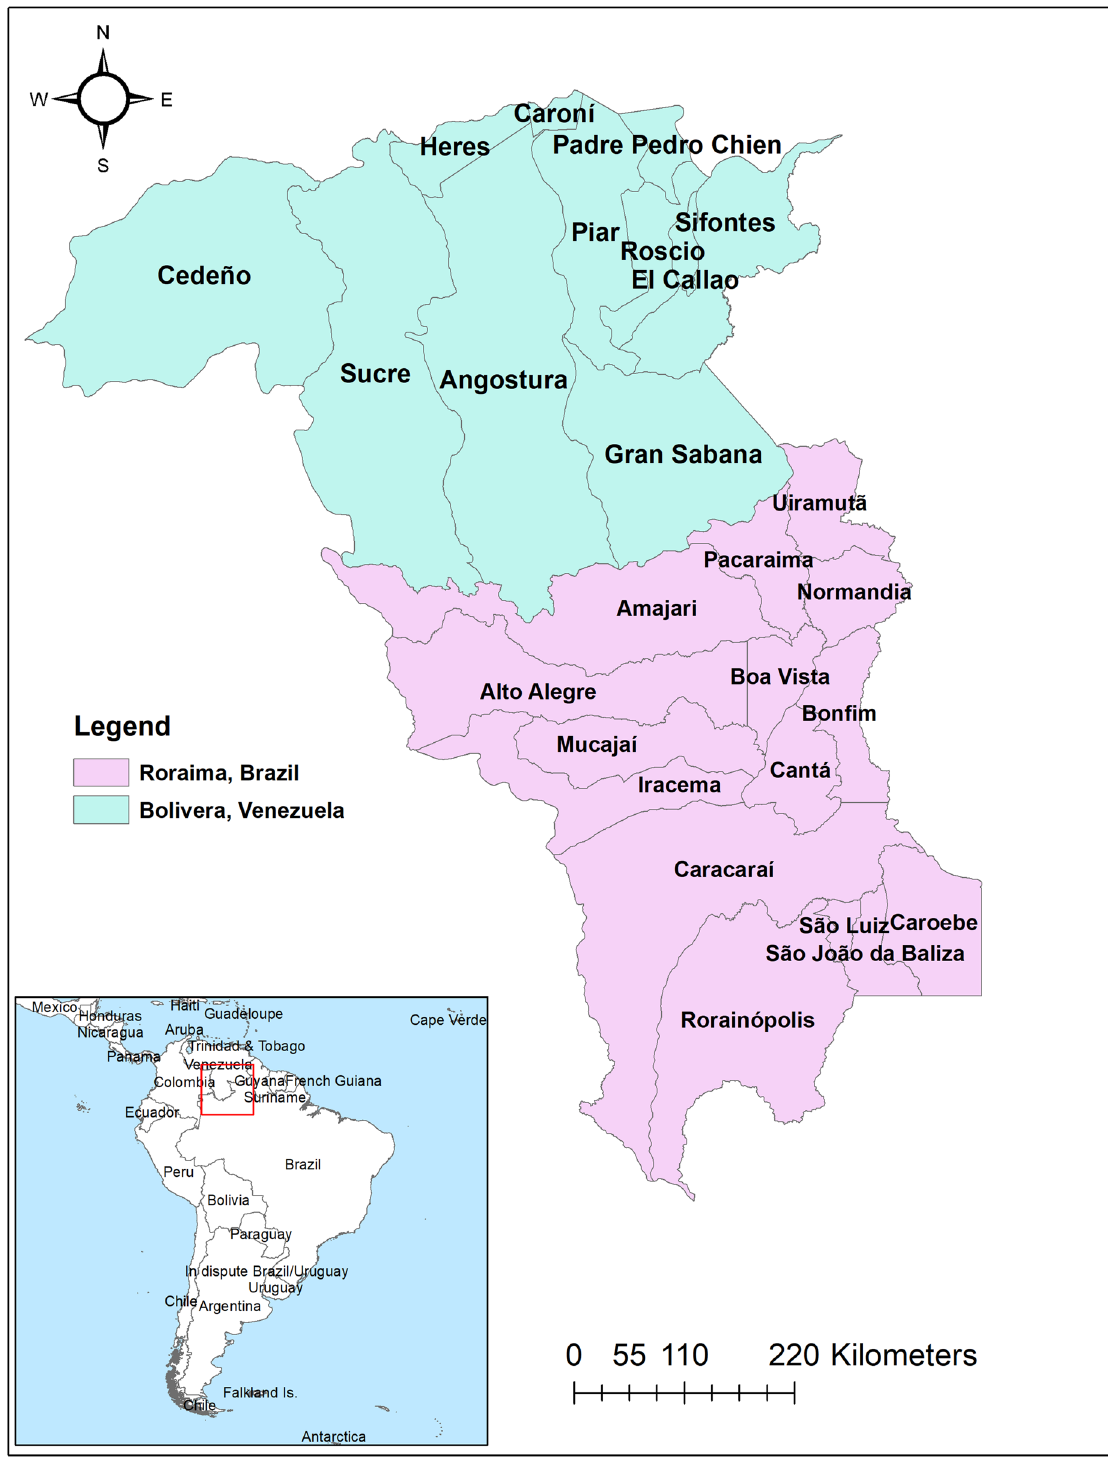
Figure 1. Map of Roraima State, Brazil and Bolivar State,